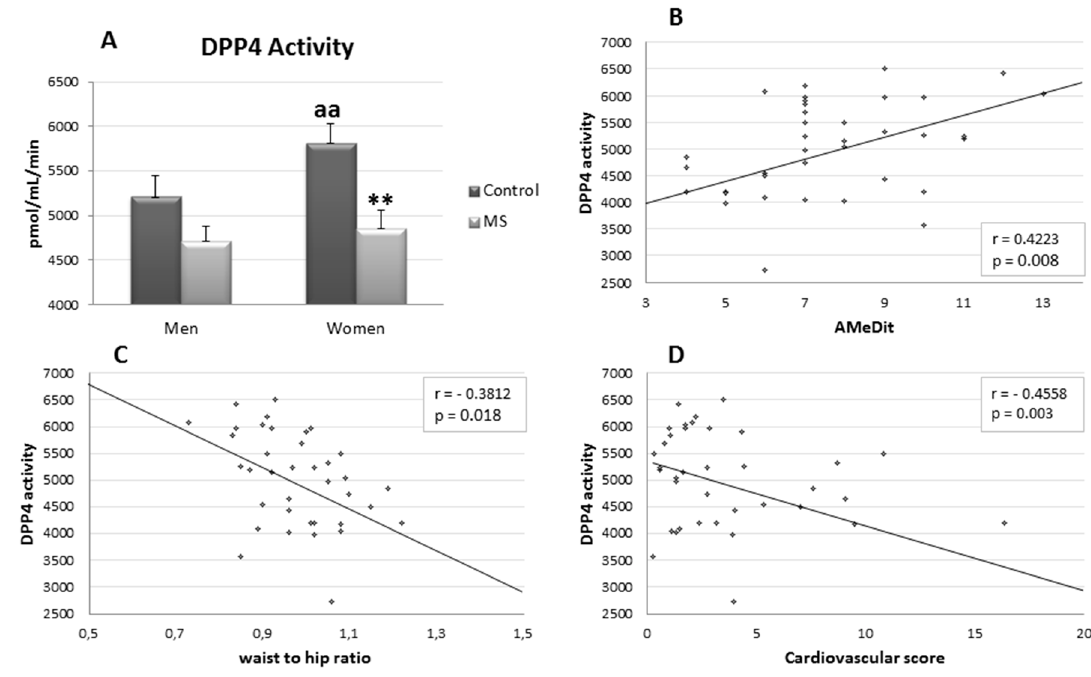
Figure 1. Graphic Panel ( A ) represents mean values ± standard error of postprandial plasma Dipeptidyl-Peptidase 4 activity (DPP4), expressed as pmol of L -Gly-Pro-4-Methoxy- β -naphtylamide hydrolyzed per minute of incubation and per mL of plasma, in the four groups studies: control men, control women, Metabolic Syndrome (MS) men and Metabolic Syndrome (MS) women. (*) indicates significant differences between metabolic syndrome v. control: ** p < 0.01. (a) indicates significant differences between women vs. men: aa p < 0.01. Graphics Panels ( B – D) represent significant ( p < 0.05) linear regressions established between DPP4 and AMeDit ( B ), waist-to-hip ratio ( C ) and cardiovascular score ( D ).